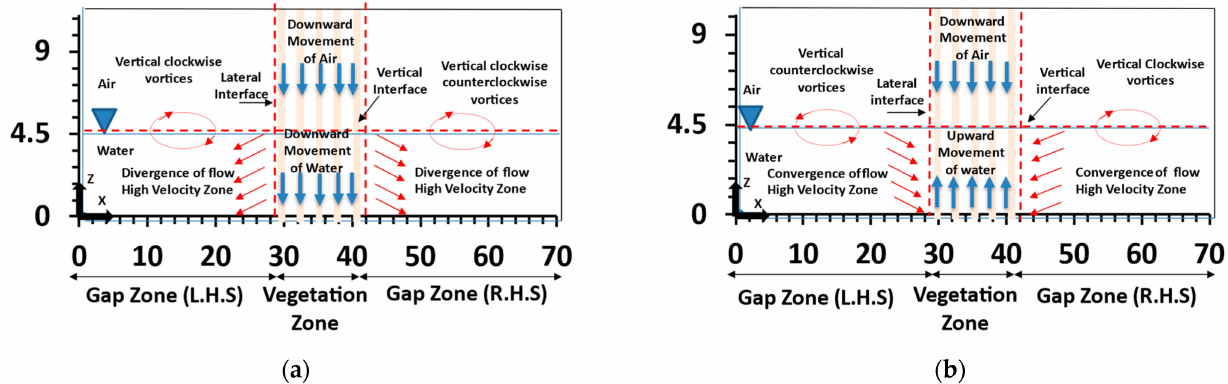
Figure 13. Schematic diagram of general vortex behavior in an emergent vegetated channel of air and water behavior along with the cross-sections ( a ) CS1; ( b ) CS2 for all the